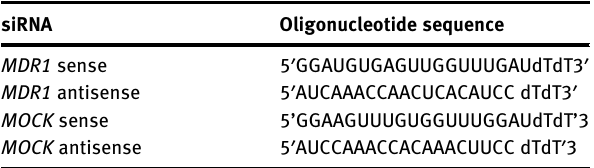
Table  : Oligonucleotide sequences of siRNA and control